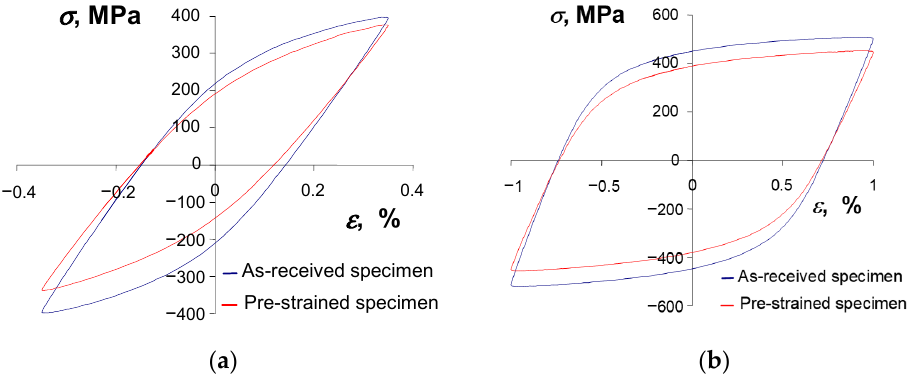
Figure 12. Hysteresis loops at 𝜀 𝑎𝑐 = 1.0%: ( a ) as-received specimen, ( b ) pre-strained specimen.